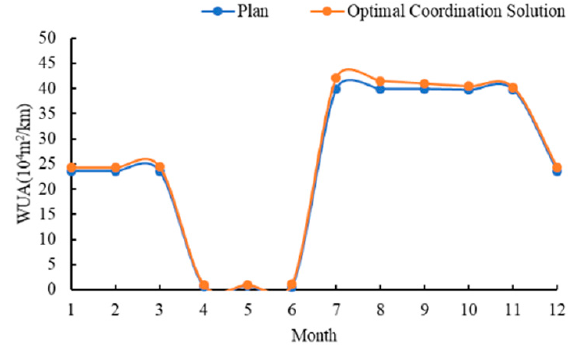
Figure 9. Habitat usable area (WUA) for both scenarios.